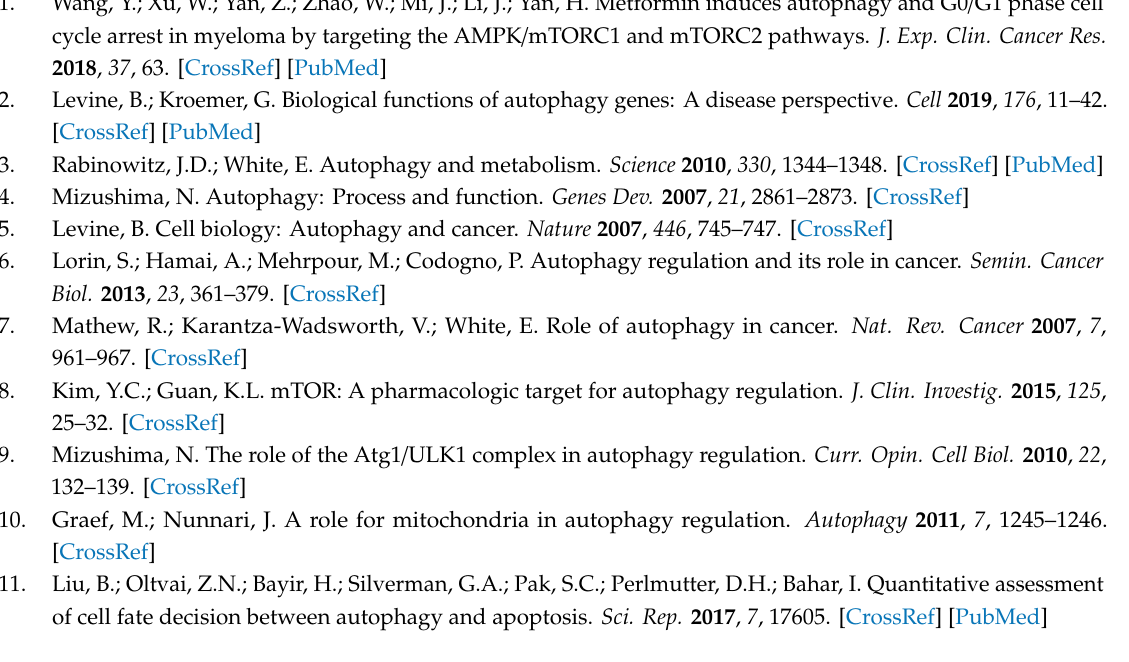
Figure S2: Population of autophagy modulators with di ff erent degrees (di ff erent numbers of associated targets); Figure S3: Additional data on the number of known and predicted targets of activators; Table S1: 225 autophagy modulators; Table S2: 993 known targets and 12 predicted targets of autophagy modulators; Table S3: 368 Predicted ATG interactions and experimental validation; Table S4: GO annotation enrichments based on ATG targets; Table